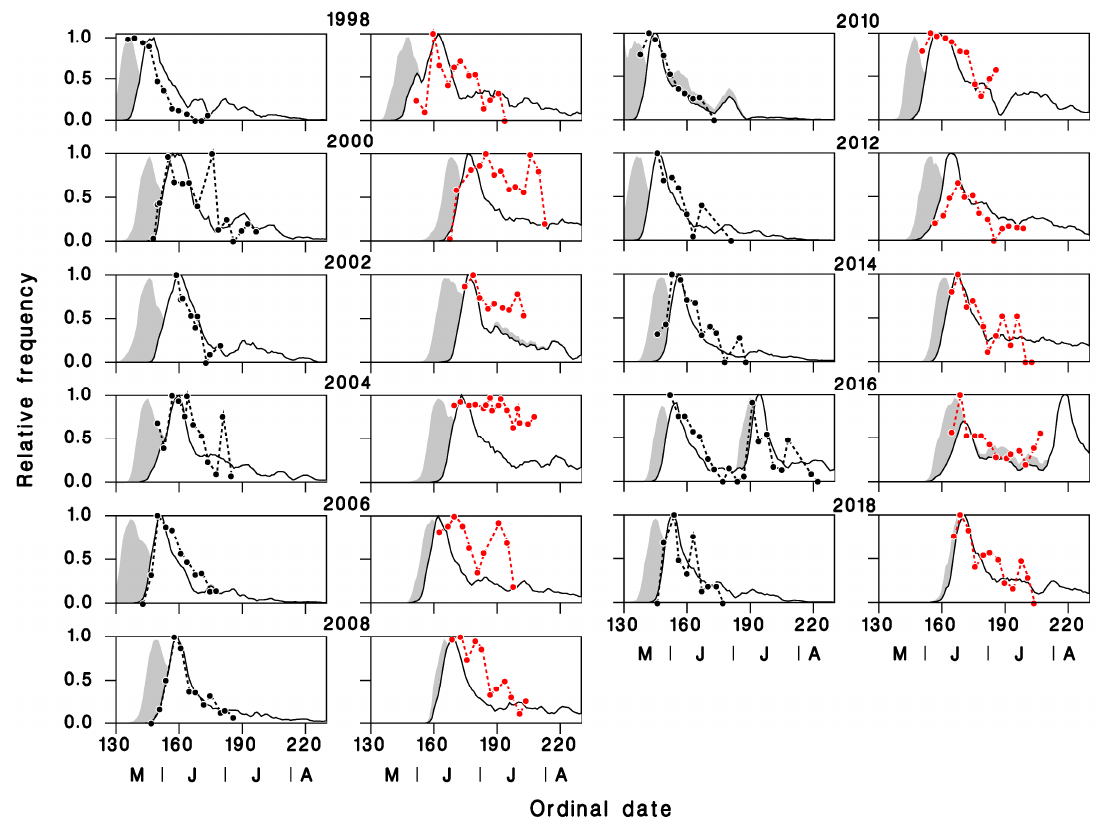
Figure 6. Three-species model output comparison with observations. Solid lines: Diapause Scenario 1 (on tree), age of diapause a D = 0.15. Shaded curves: Scenario 2, overwintering in the cocoon on the ground. Observed ( • ) seasonal oviposition trends by Tranosema rostrale , in even years between 1998 and 2018 (validation subset). Black symbols: Armagh; red symbols: Epaule. In 2016, the line represents oviposition by the first two generations of the parasitoid.